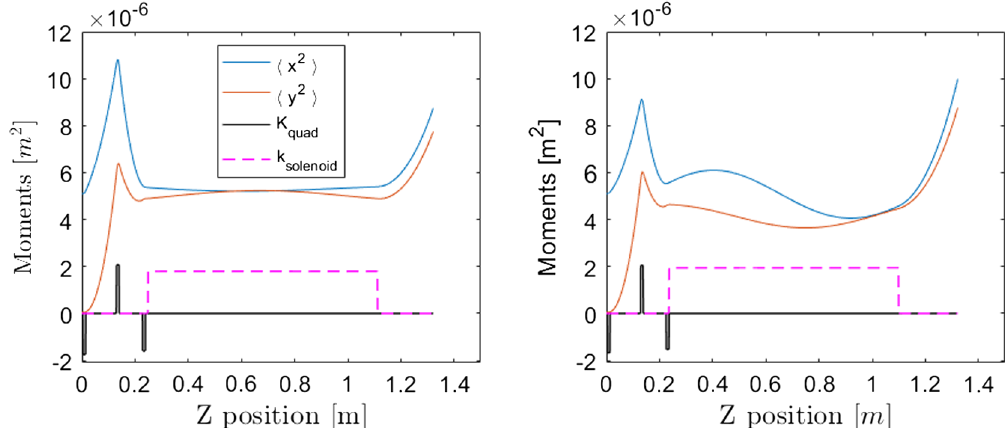
FIG. 8. rms beam size is plotted for two different optimization using the FOM from Eq. (46). The left side uses weight values of ϵ ; ϵ 1 , 0 while the right side uses ϵ ; ϵ 0 , 1. A 5-mA beam current and the same set of initial conditions are used for both 1 2 ¼ 1 2 ¼ optimizations. The optimizations minimized the FOM from Eq. (46) at roughly the center of the solenoid ( Z ¼ 0 . 722